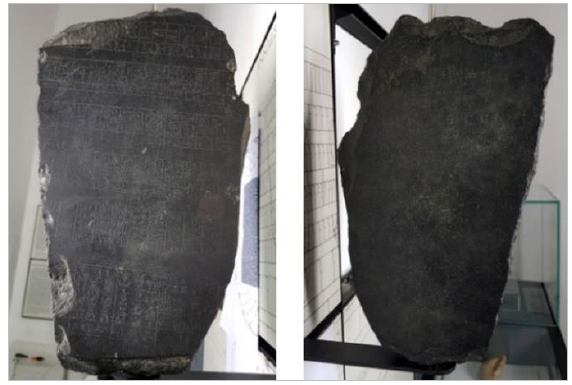
Figure 1: Pictures of verso and recto of the Palermo